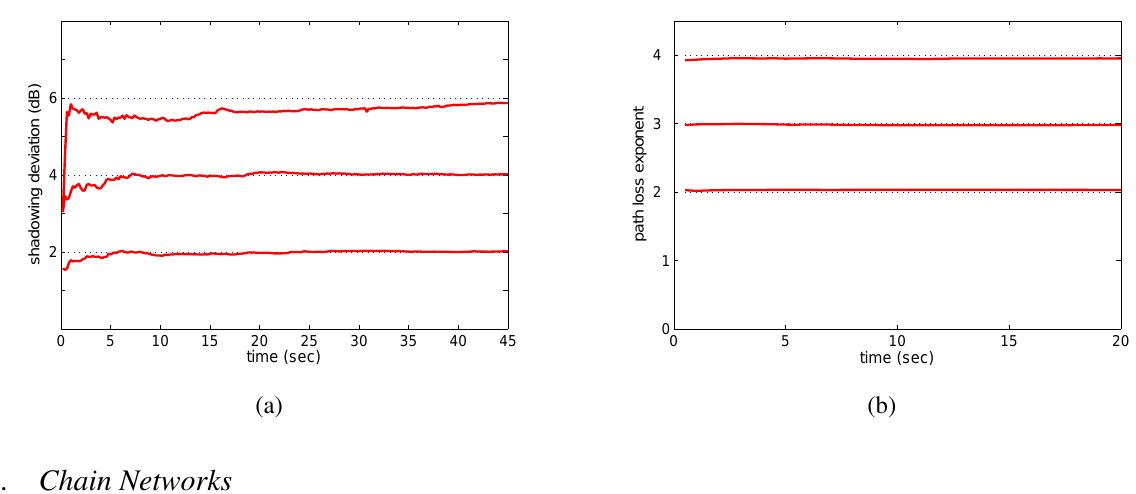
Figure 5. Channel parameter estimation in an eight-node chain network. (a) Estimated channel variance ˆ σ over time for β = 4 and σ = 2, 4, and 6. (b) Estimated path loss dB dB exponent ˆ β over time for σ = 4 and β = 2, 3, dB